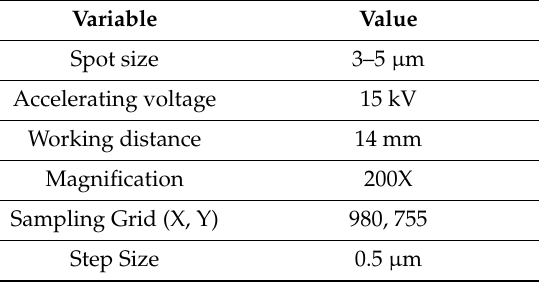
Table 2. SEM settings used for EBSD data